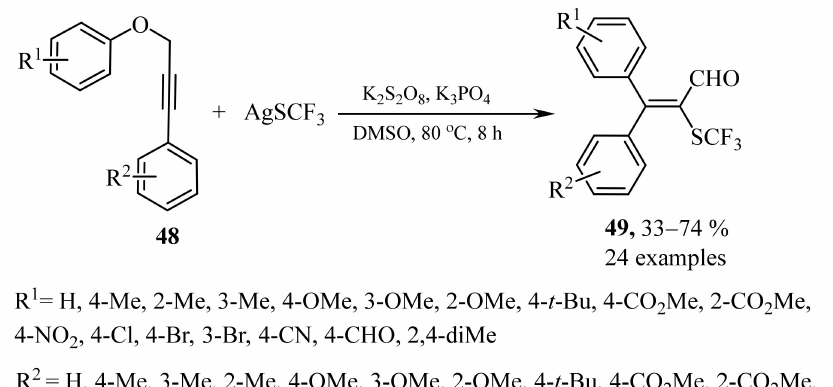
The reaction features excellent conversion of aryl propynyl ethers into SCF 3 -containing α , β -unsaturated aldehydes through a radical pathway (Scheme